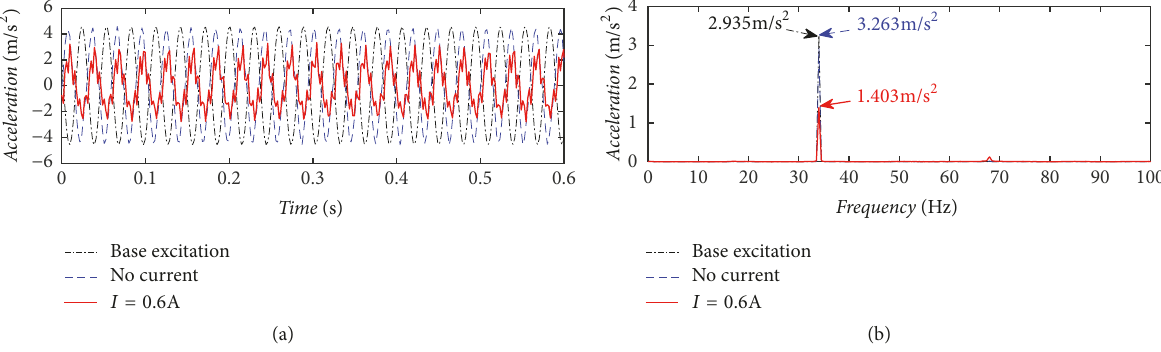
from 1.45 mm to 0.17 mm and the isolation performance becomes much better than that of the former case.